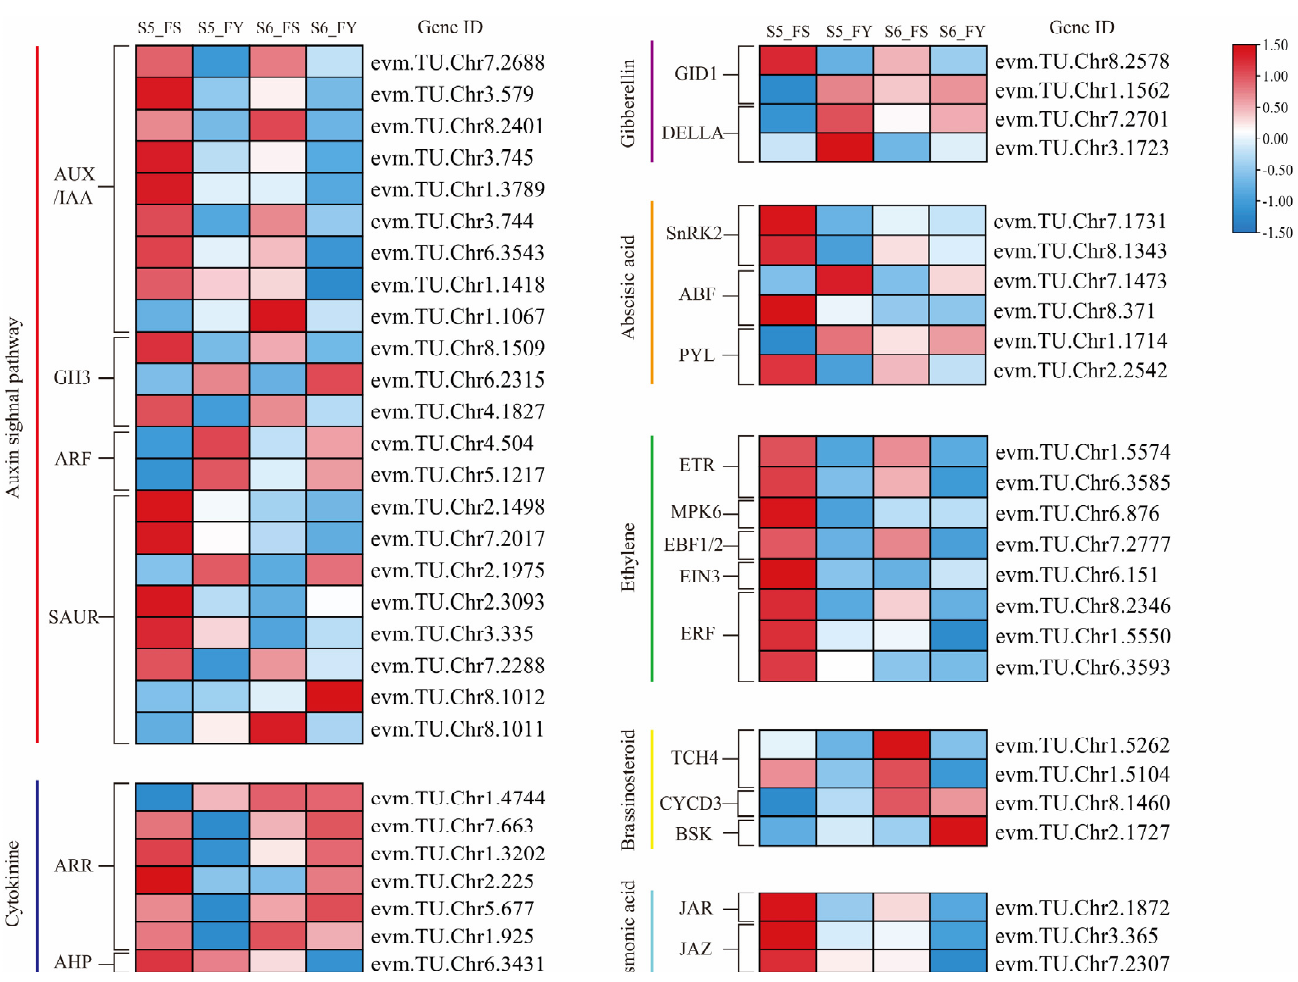
Figure 6. The expression profiles of DEGs in the plant hormone signal transduction pathways. Log 2 FPKM values were used for the heatmap